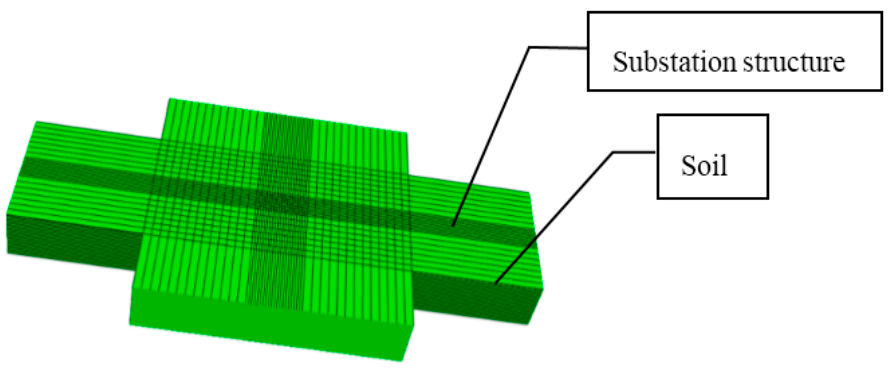
Figure 7. Finite element model of equipment.